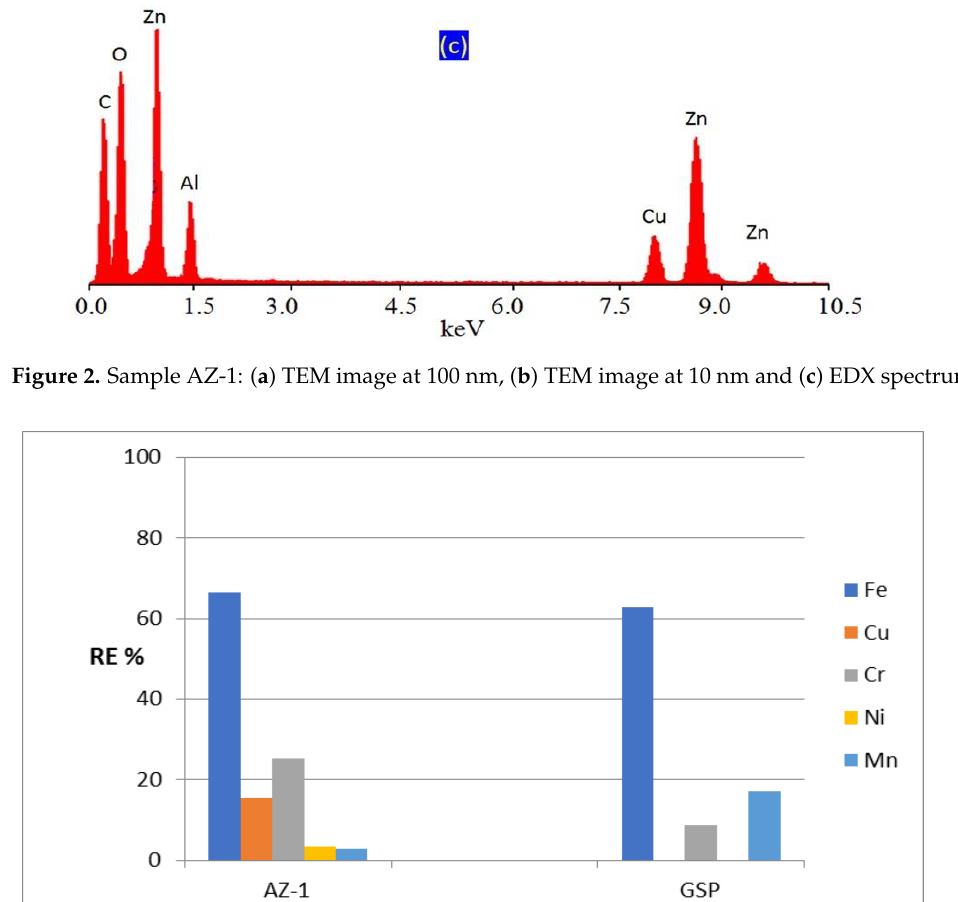
Figure 3. The removal percentage of heavy metals from water in an extremely acidic medium for the AZ-1 samples and the commercial material GreensandPlus (GSP).